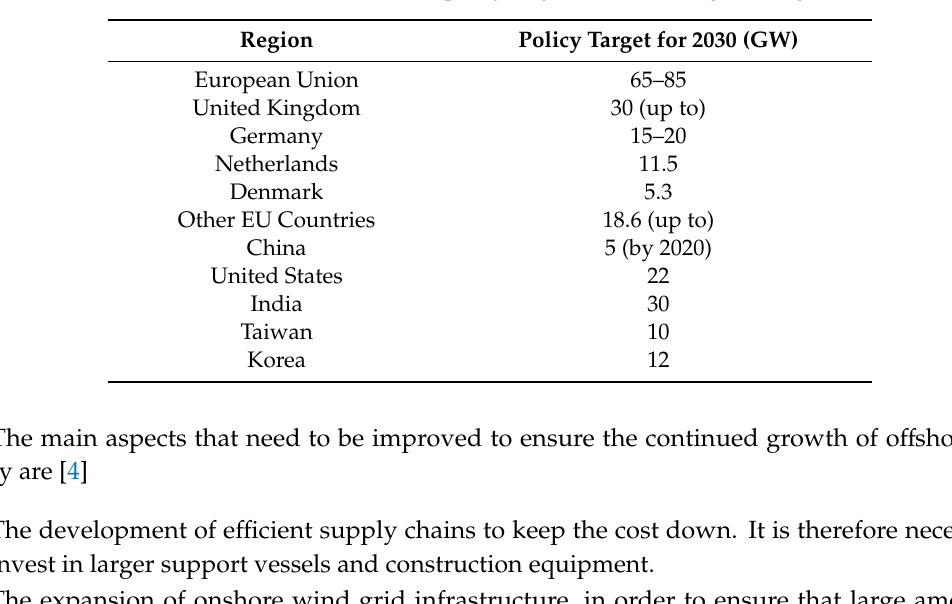
Table 1. : O ff shore wind total capacity targets for di ff erent global